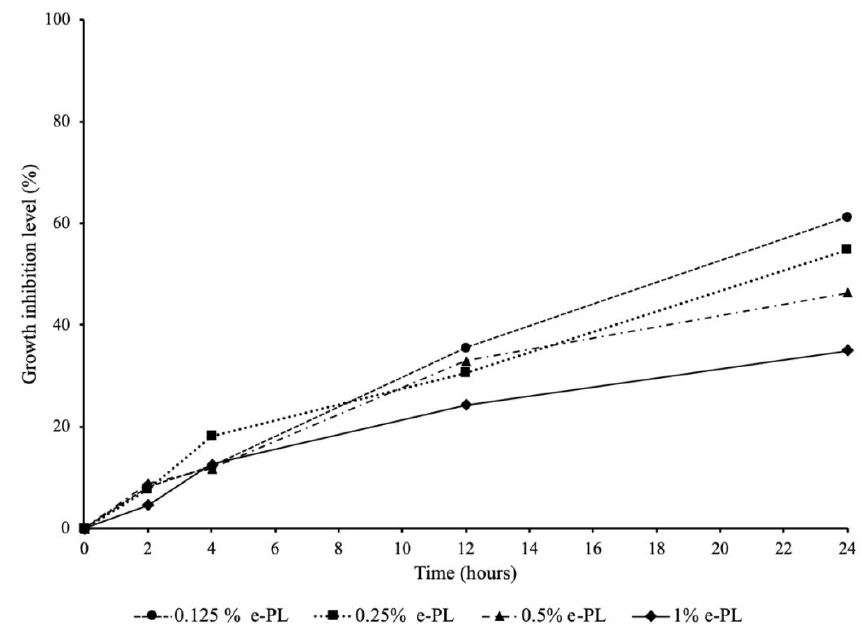
Figure 2. Antibacterial effect of ε -polylysine on the growth of P. gingivalis .